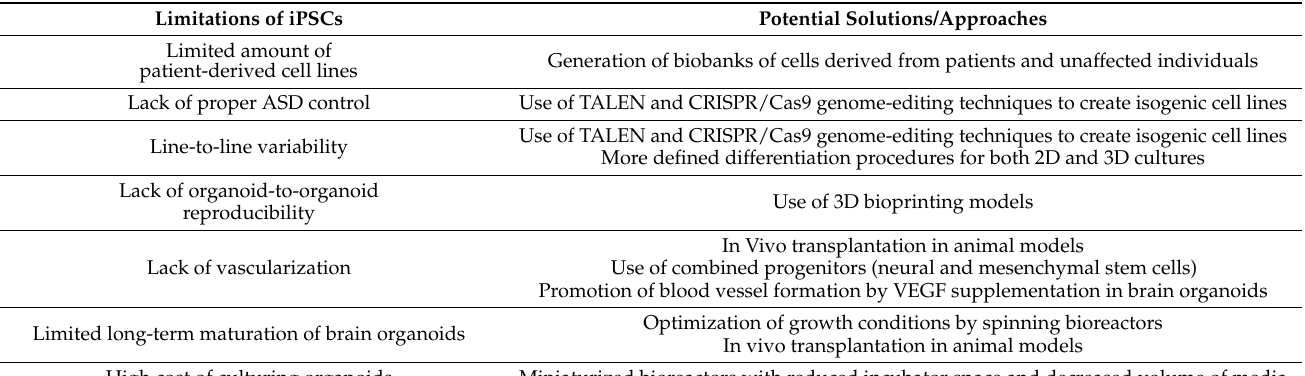
Table 3. Current limitations of iPSCs and potential solutions/approaches in ASD